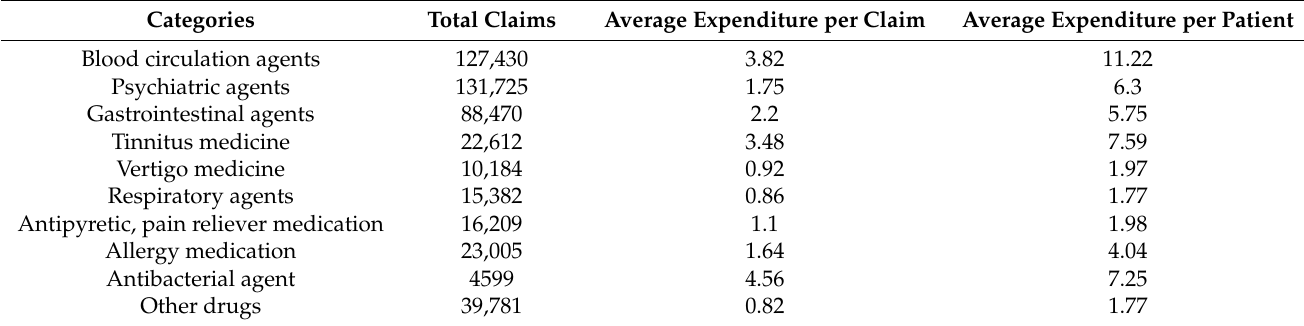
Table 4. High-frequency drug care for patients with